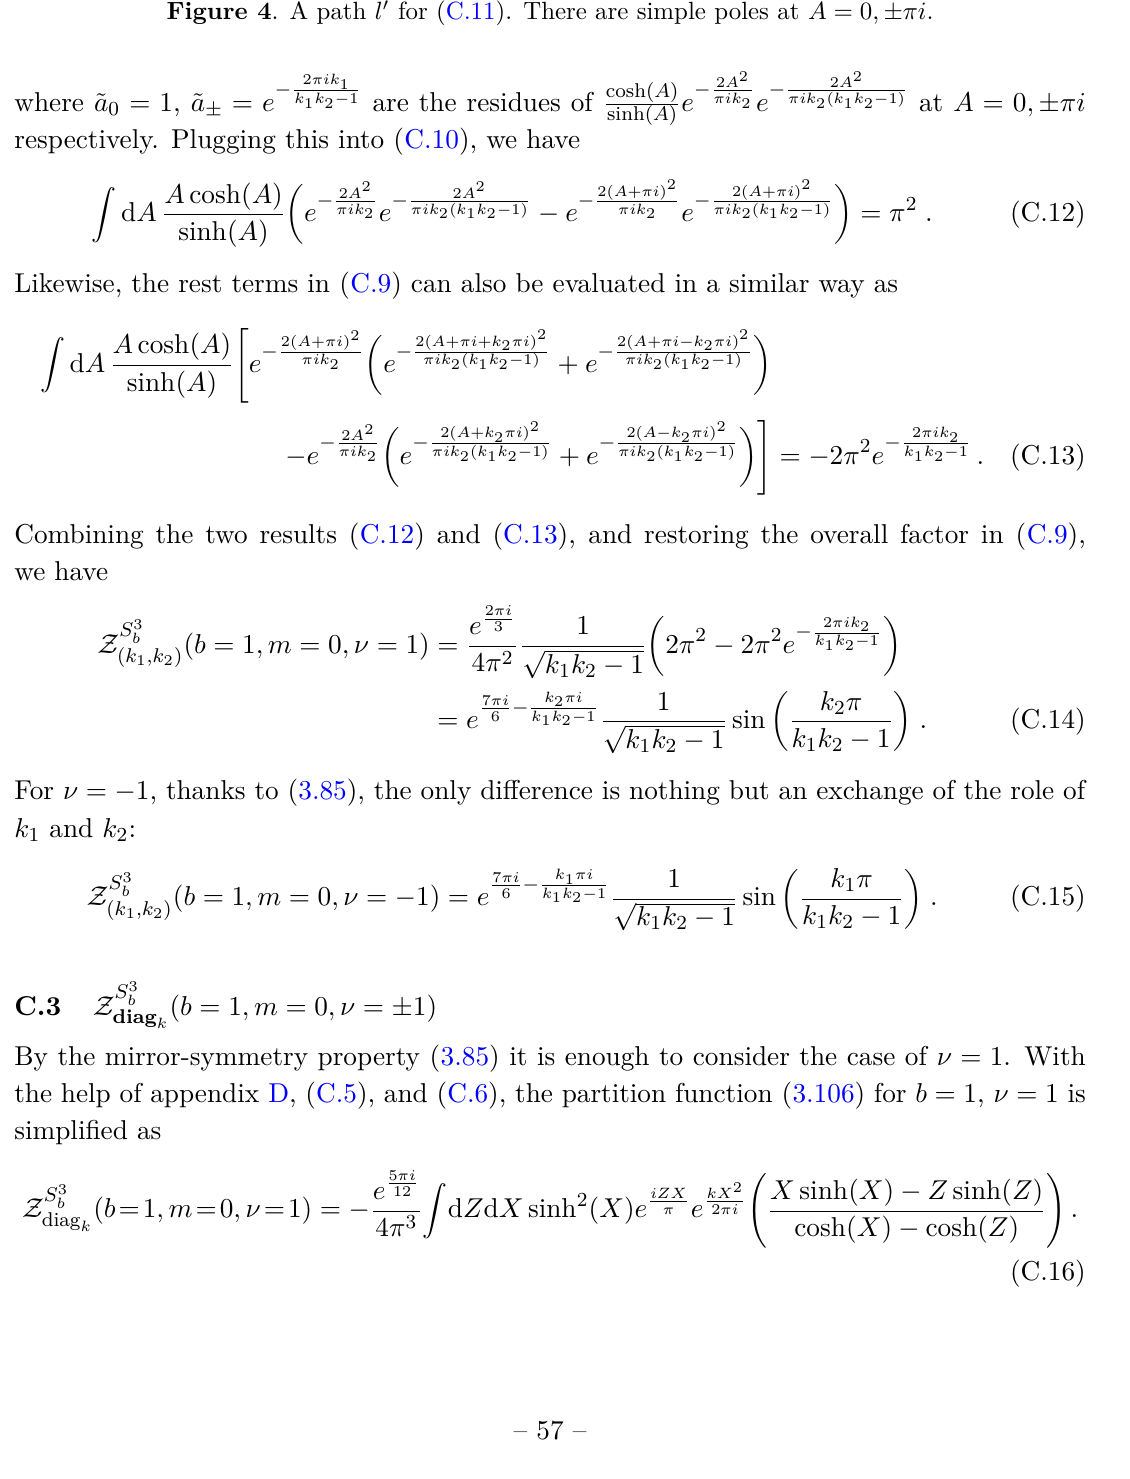
Figure 4 . A path l 0 for (C.11). There are simple poles at A = 0 , ± πi